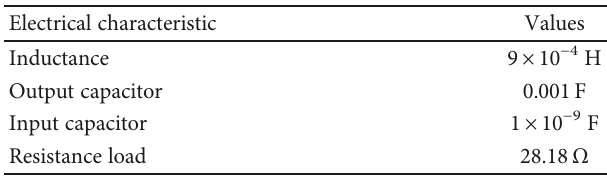
Figure 4: Schematic diagram of the PV system with MPPT. Table 1: DC-DC booster converter design values.